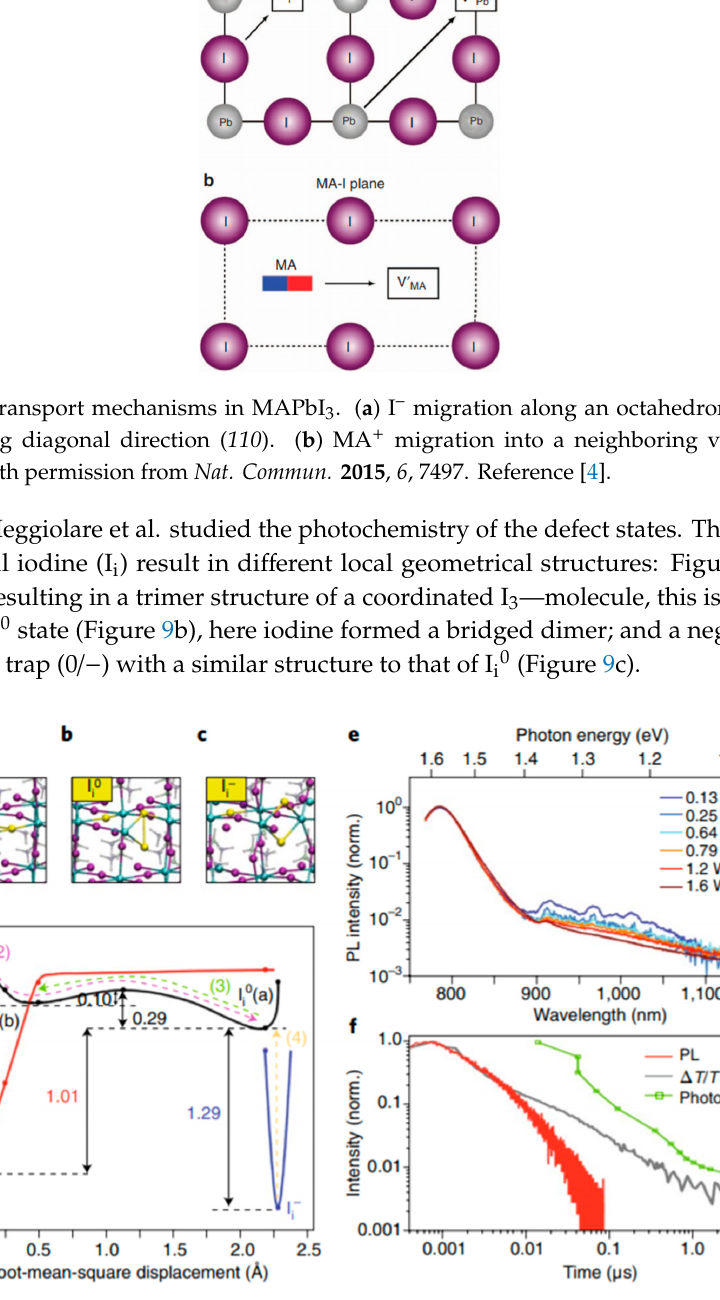
8 of 21 Figure 7. Calculated transition energy levels of various types of point defects in MAPbI 3 (interstitials (i), ion substitutions and vacancies (V) are indicated). The formation energies of neutral defects are shown in parentheses. The acceptors (red, trapping electrons) and donors (blue, trapping holes) are ordered by the formation energies (from left to right). Reproduced with permission from Adv. Mater. 2014 , 26 , 4653–4658 . Reference [17]. Similar to Yin et al. other theoretical work suggests that Pb 2+ , I − and MA + vacancies are predominant and only create shallow traps [18]. On the other hand, it can be argued that simple trapping and un-trapping of photogenerated charge might not give a complete picture. The slow charge carrier dynamics and stability-threatening phenomena, such as current-voltage hysteresis, are not readily explained by the presence of shallow traps and only the limited amount of deep level traps. Ion defect transport has been widely observed in perovskite material and is another possible